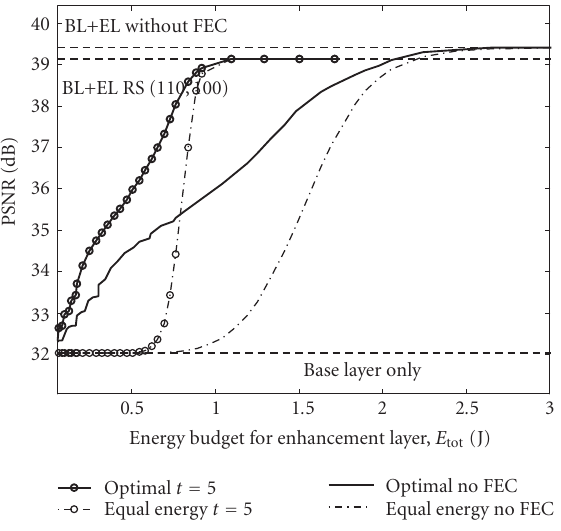
Figure 10: Performance of the proposed approach and equal energy distribution for di ff erent RS codes: RS(110,100) and RS(160,100) (BPSK, B T = 200KHz).